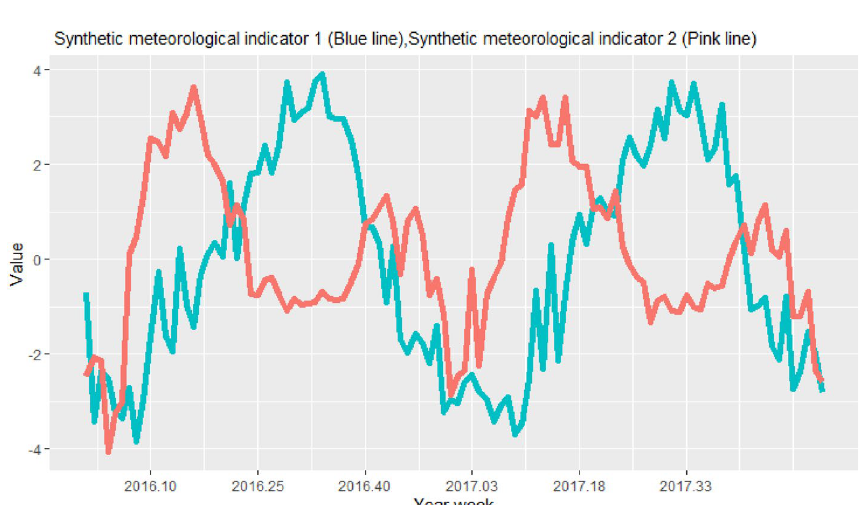
Figure 4. Time series of synthetic meteorological indicator 1 (mainly correlated with precipitation variables) and synthetic meteorological indicator 2 (mainly correlated with temperature variables) from 2016 to